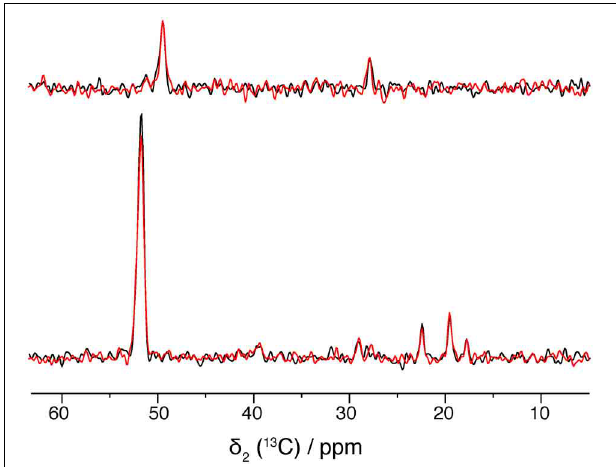
FIGURE 6 | 1D traces at 49.5ppm (top) and 51.8ppm (bottom) of 20ms DARR spectra from a freshly prepared BmrA apo sample (in black) and from a same sample after storage at 4 ◦ C for several months (in blue). Both spectra were recorded with 16 scans.